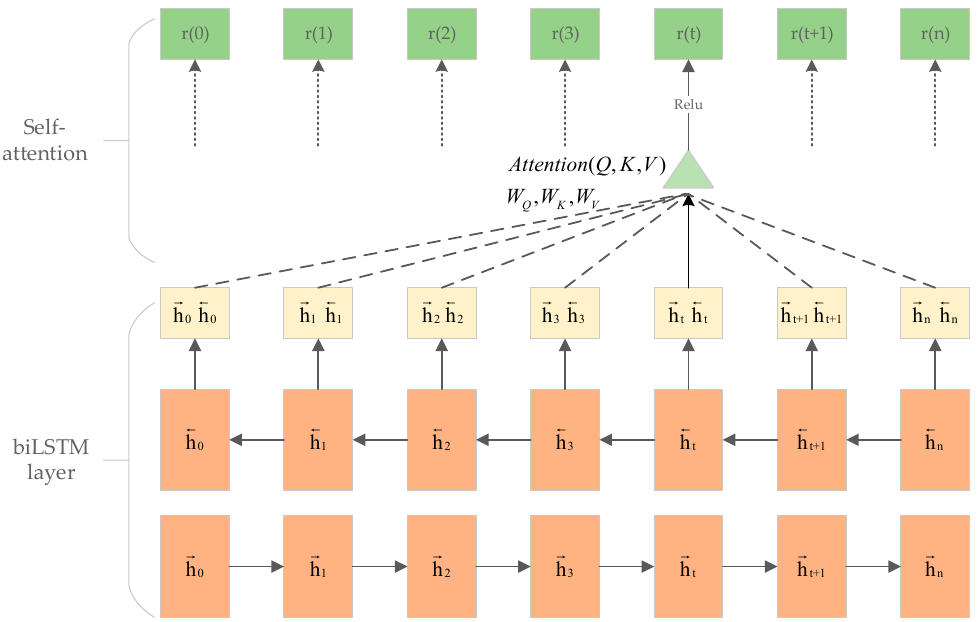
Figure 1. The architecture of attention-based bidirectional Long Short-term Memory (Att-biLSTM). The biLSTM layer captures input data and generates embeddings from two directions. The embedding of each token from two directions is concatenated into one vector as the output of the biLSTM layer. Then, the vectors go through a multi-head self-attention layer. A relu function activates the outputs of the attention layer. Dropout is applied in the biLSTM layer. This part is a part of the encoder in our model.